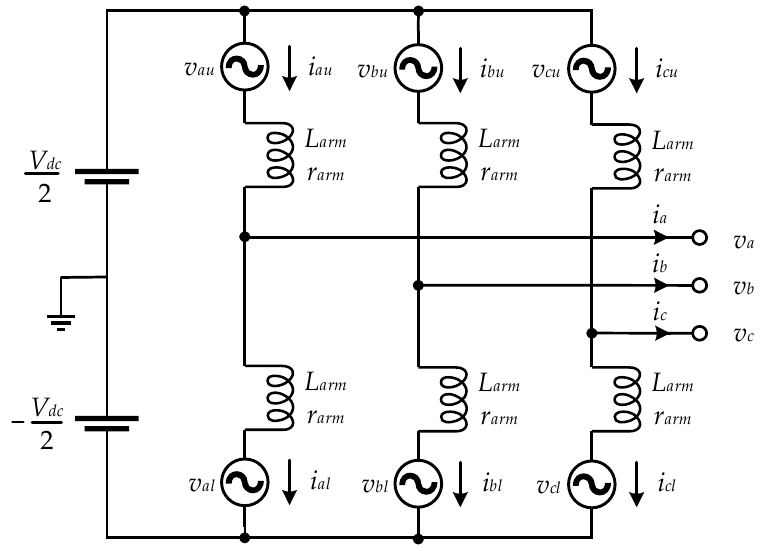
Figure 6. Equivalent circuit of three-phase MMC.